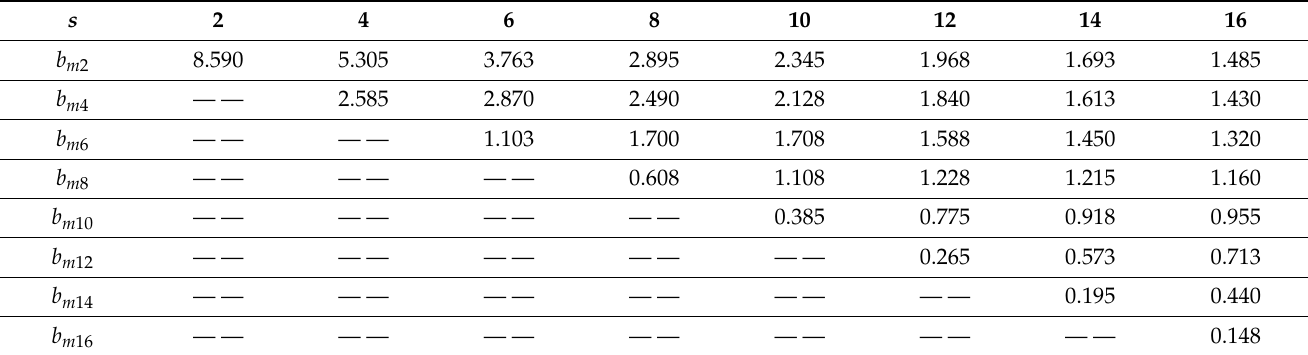
Table 3. Longitudinal lengths of PMs with an even carrier ratio.